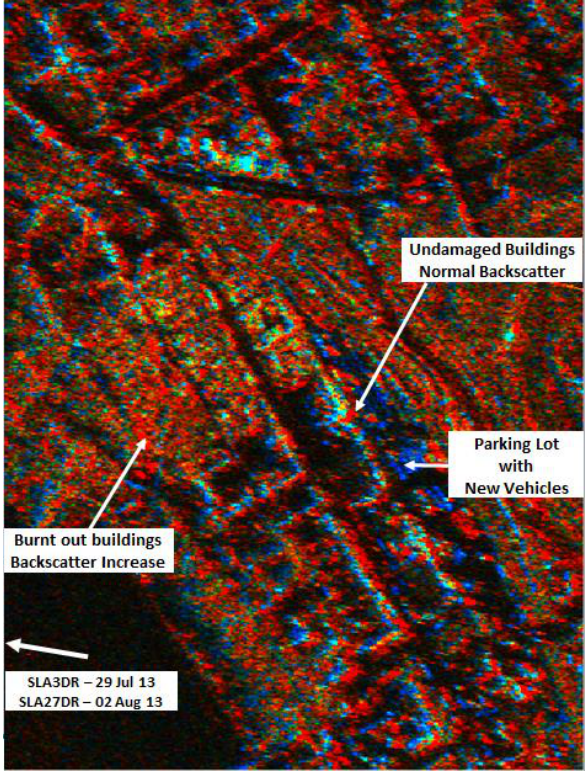
Figure 16. Comparing change between image dates